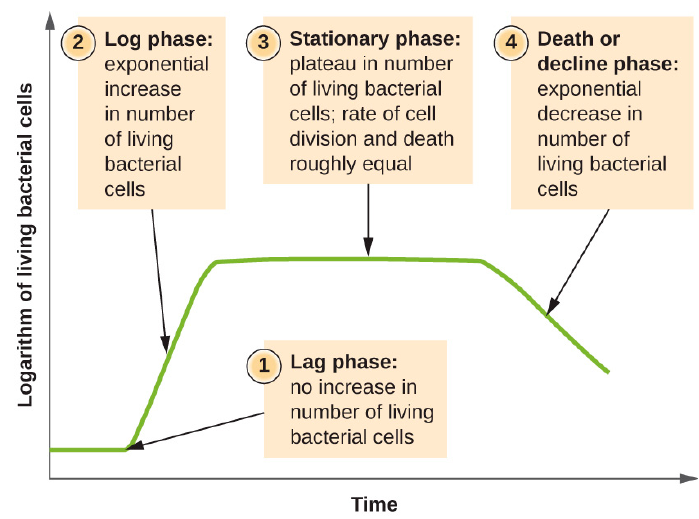
Figure 2. This graph shows the relation between time and the growth of bacteria in a laboratory environment